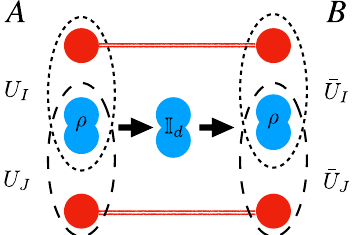
FIG. 5. Illustration of our quantum PQC for the case n ¼ 2 . To encode a 2-qubit state ρ (blue), Alice applies the dephasing unitaries U I and U J to the system and one half of an ebit (red) each, where I and J canbe anymutuallyunbiasedbases. Thismaps ρ into the maximally mixed state exactly, so that an eavesdropper cannot learn anything about ρ even if she was initially entangled with part of it. Bob, in order to decode, applies the conjugate of the two above unitaries and thereby retrieves the state